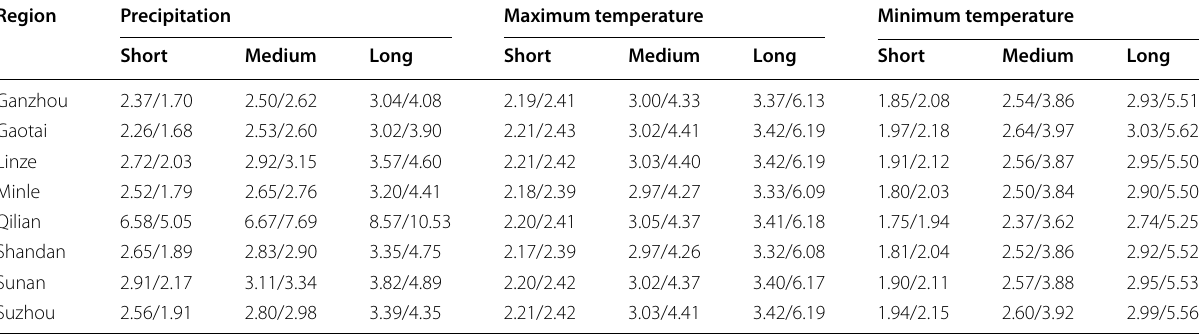
Table 2 Increase in precipitation, maximum temperature, and minimum temperature in the short term (2025–2049),